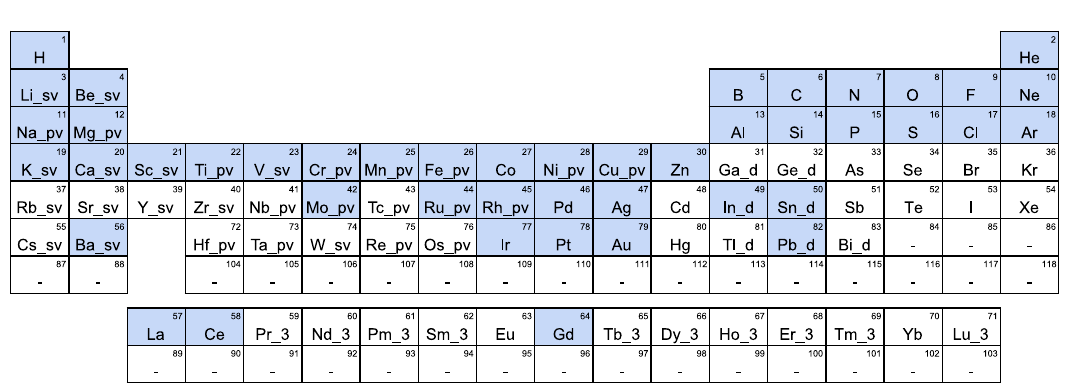
Fig. 6 The 45 elements supported by PFP are colored in the periodic table. Pseudopotentials used in the DFT calculations for the PFP crystal dataset are also shown in the periodic table. These are supplied with the VASP package, version 5.4.4, and chosen by the Materials Project 18 .